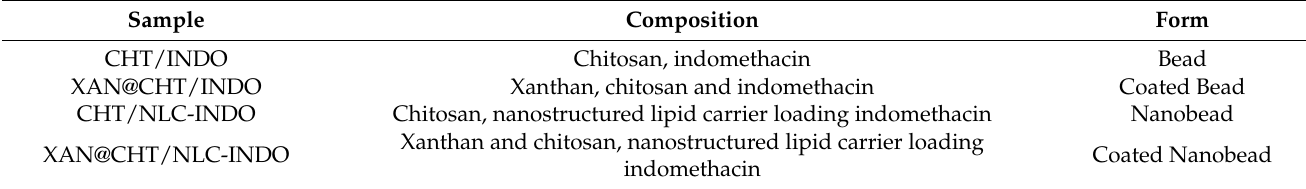
Table 2. Composition of the prepared beads and nanobeads encapsulating 2%